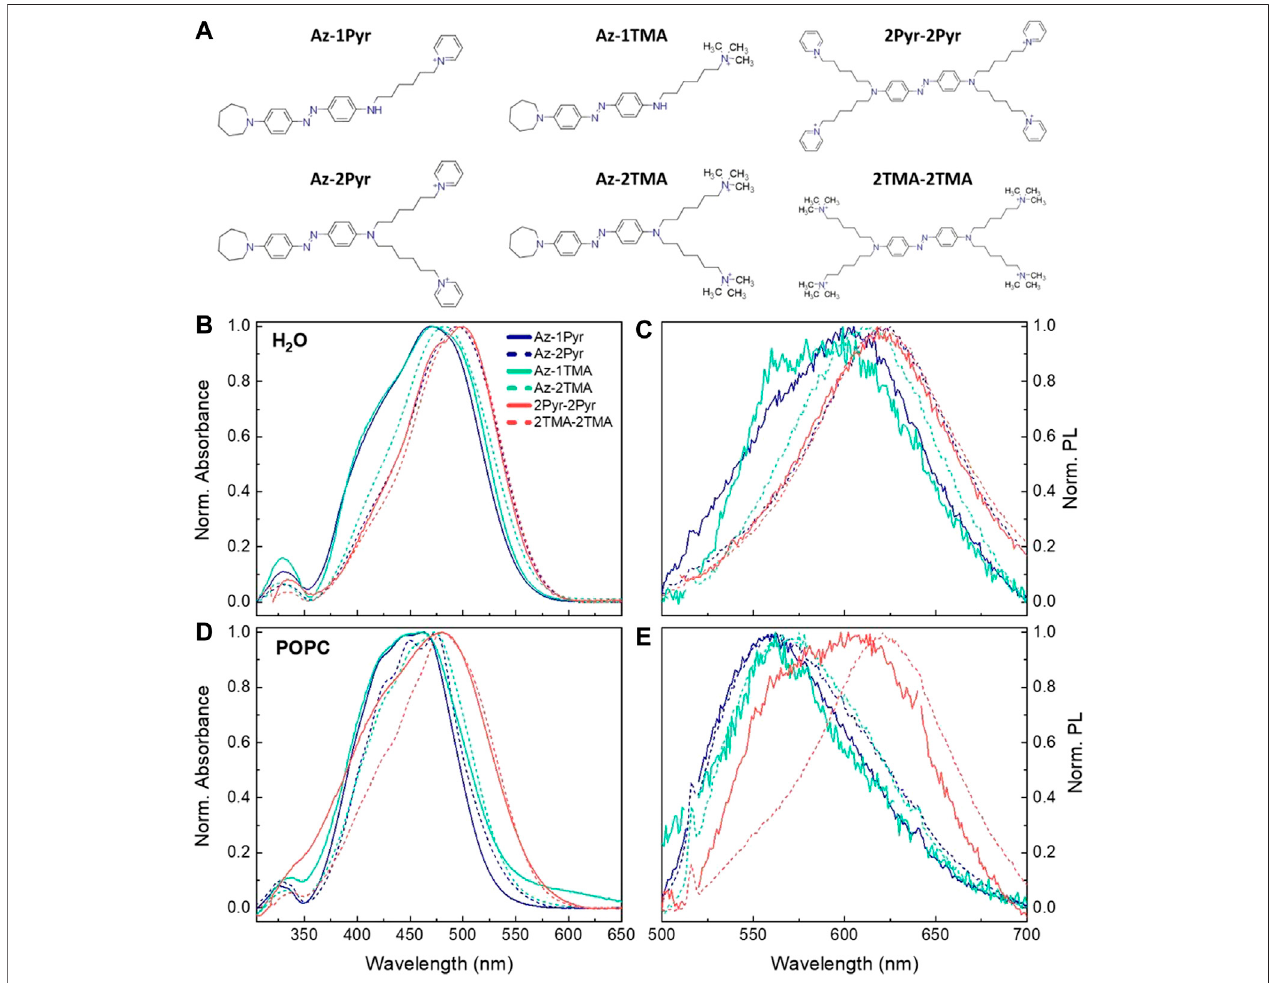
FIGURE1|(A) Chemicalformulasofthesixdesignedazobenzenederivatives. UV-VisandPLspectrainwater (B,C) andinPOPCliposomesuspension (D,E) .PL spectrahavebeenacquiredwith fi xedexcitationat470 nmandwerenormalizedtobothlampintensityandgroundstateabsorption.Ascatteringbackgroundpro fi lehas been subtracted from the POPC absorbance